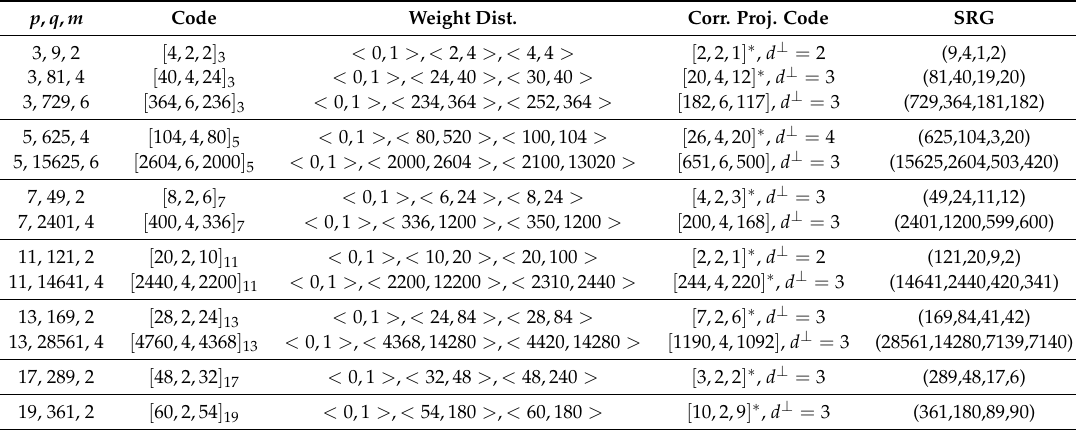
Table 5. Two-weight trace codes from powers of 6.